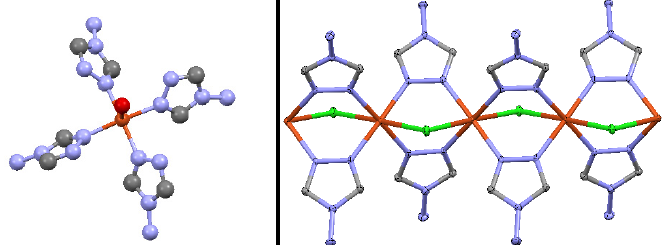
Figure 2. Thermal ellipsoid (50%) plot of II ( left ) and III ( right ). H-atoms and − anions in II , and non-coordinated Cl − anions and water molecules in III were omitted PF 6 for clarity. The nitrogen atoms are depicted in blue, the carbon atoms in grey, the chloride ions in green and the copper atoms in